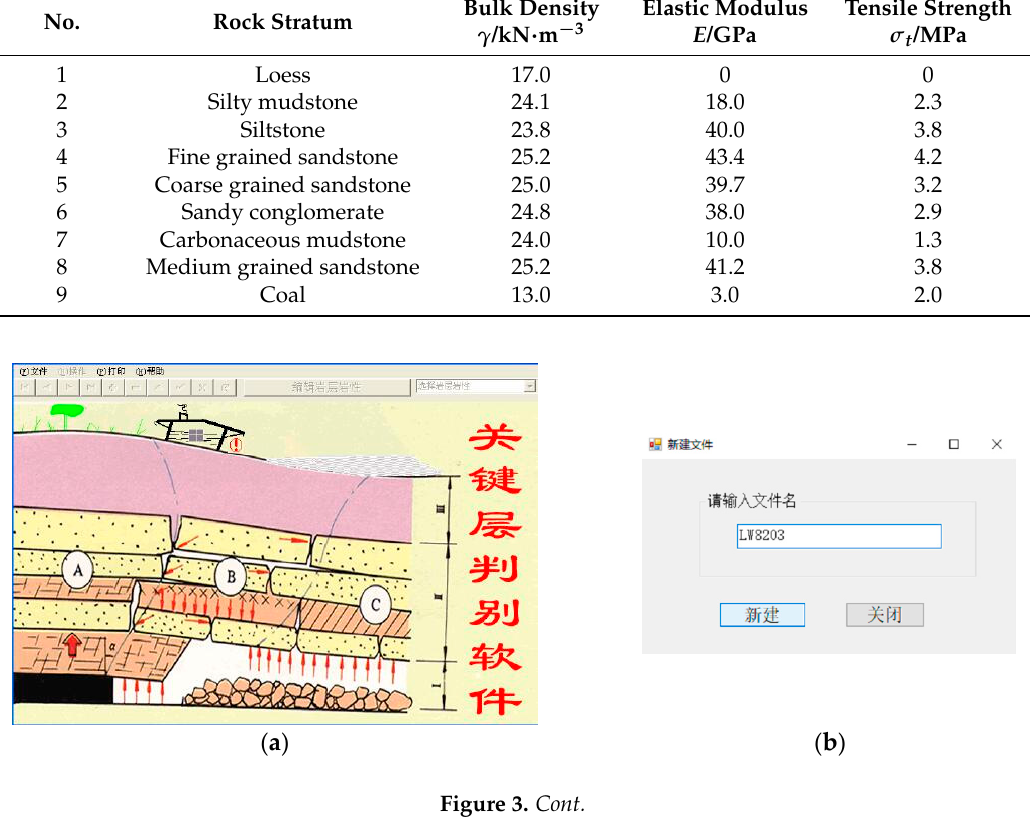
Figure 2. Stratigraphical column obtained from the detective borehole.